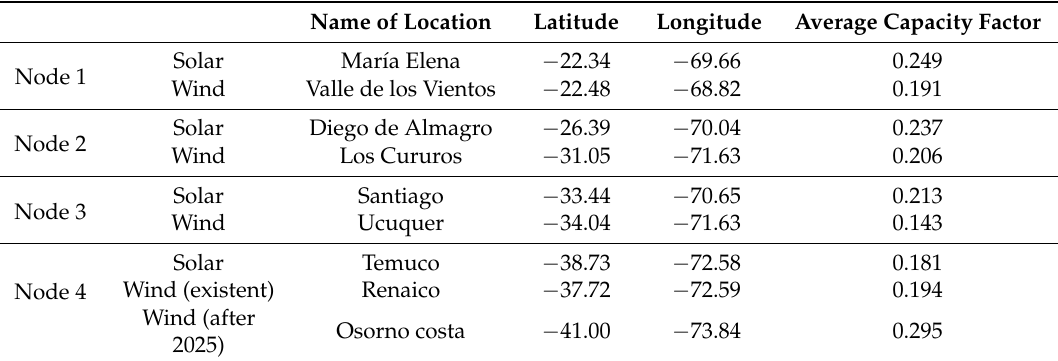
Table 3. Locations used for solar and wind data for each node.